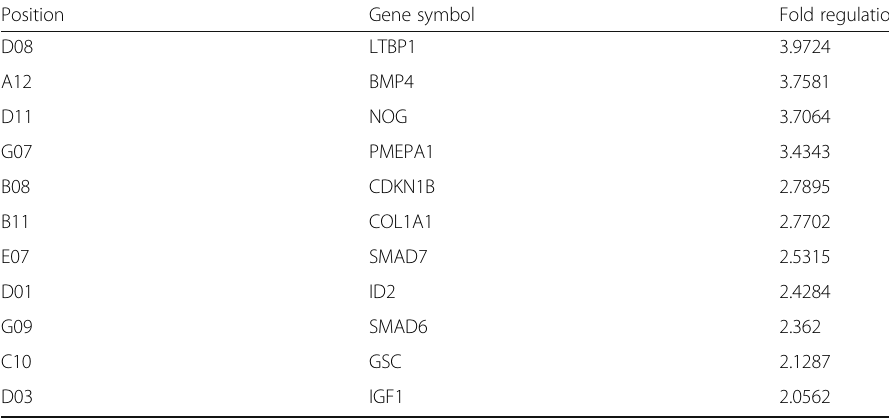
Table 3 Upregulated genes in TGF- β 1 knockout cell lines Position Gene symbol Fold regulation D08 LTBP1 3.9724 A12 BMP4